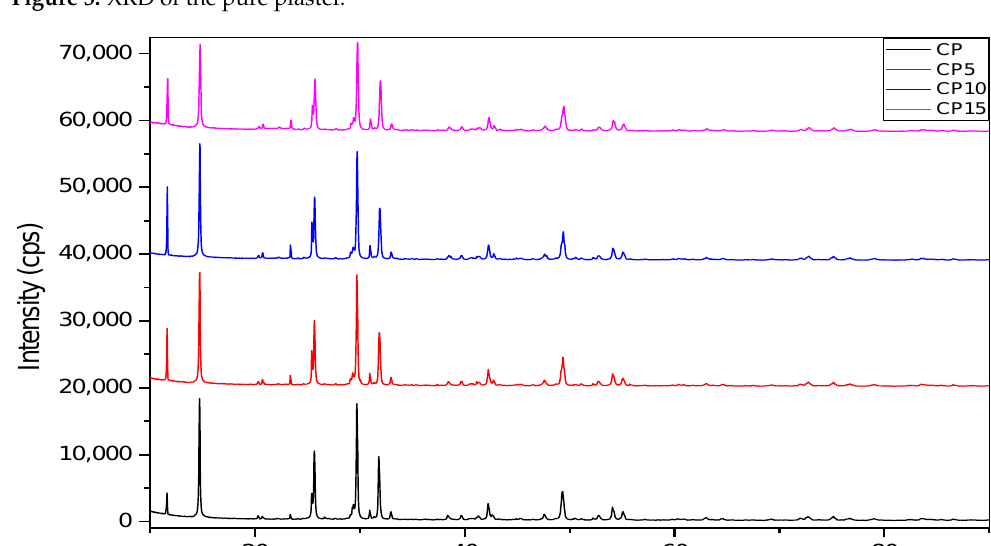
Figure 5. XRD of the pure plaster.